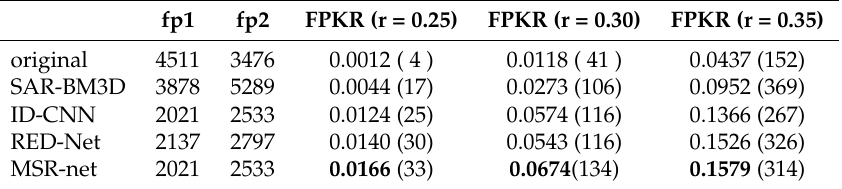
The value inside brackets is the number of feature points. The bold number represents the optimal value in each column.